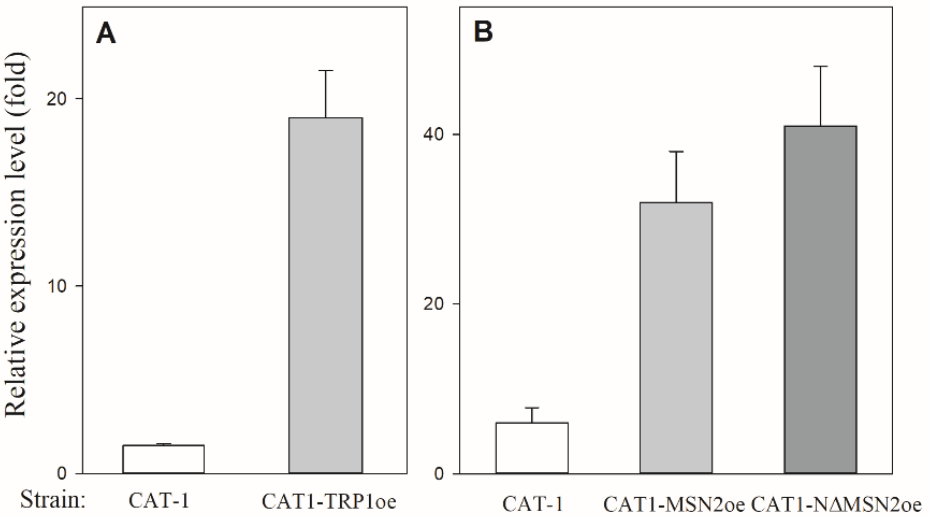
Figure 3. Relative expression levels of TRP1 ( A ), and MSN2 , and N ∆ (1-153) MSN2 genes ( B ). Yeast cells were cultured to the midexponential growth phase in YP-20 g/L glucose medium. The total RNA was prepared and reverse transcribed. Then, qRT-PCR analysis was performed. The cycle thresholds for each gene were normalized to the ACT1 gene and the relative induction fold of the recombinant overexpressing strains compared with the control strain CAT-1 is shown.